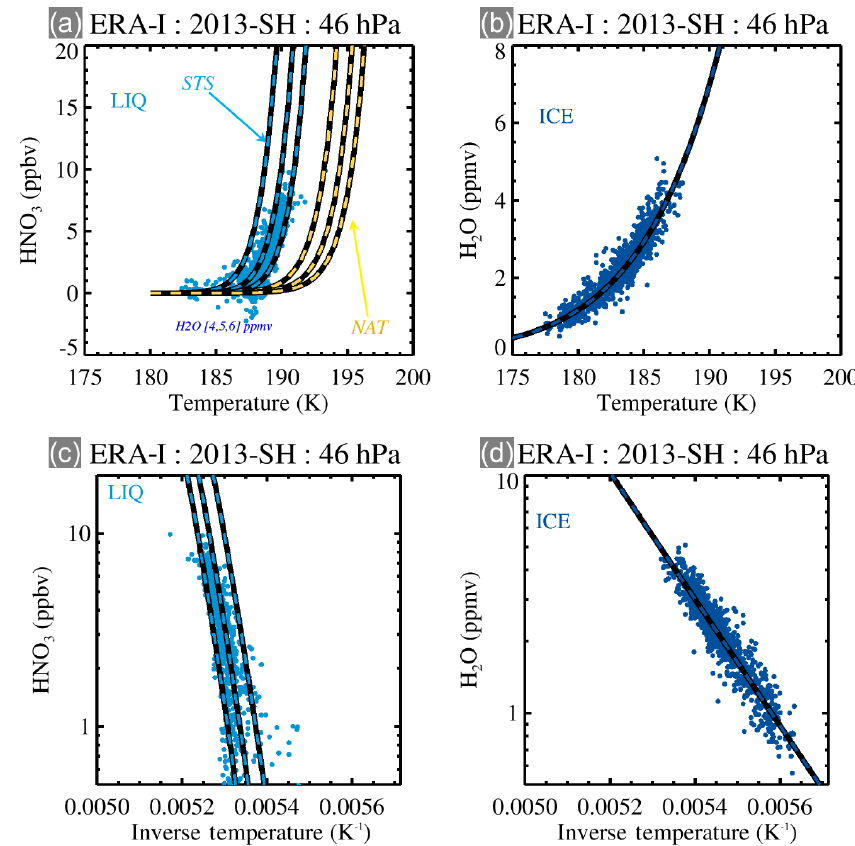
Figure 11. Scatterplots of coincident MLS HNO 3 and H 2 O vs. ERA-I temperature for PSCs classified by CALIOP on the 46hPa pressure level in the 2013 Antarctic winter. (a) MLS HNO 3 vs. ERA-I temperature for liquid ( LIQ ) PSCs. The theoretical equilibrium uptake of HNO 3 by STS is shown for representative ambient H 2 O values by the cyan–black dashed lines. The yellow–black dashed lines show the corresponding NAT equilibrium curves. (b) MLS H2O vs. ERA-I temperature for ice ( ICE ) PSCs. The blue–black dashed lines indicate the theoretical equilibrium for the frost point temperatures. (c, d) The same as for panels (a, b) except plotted as log mixing ratio vs. inverse